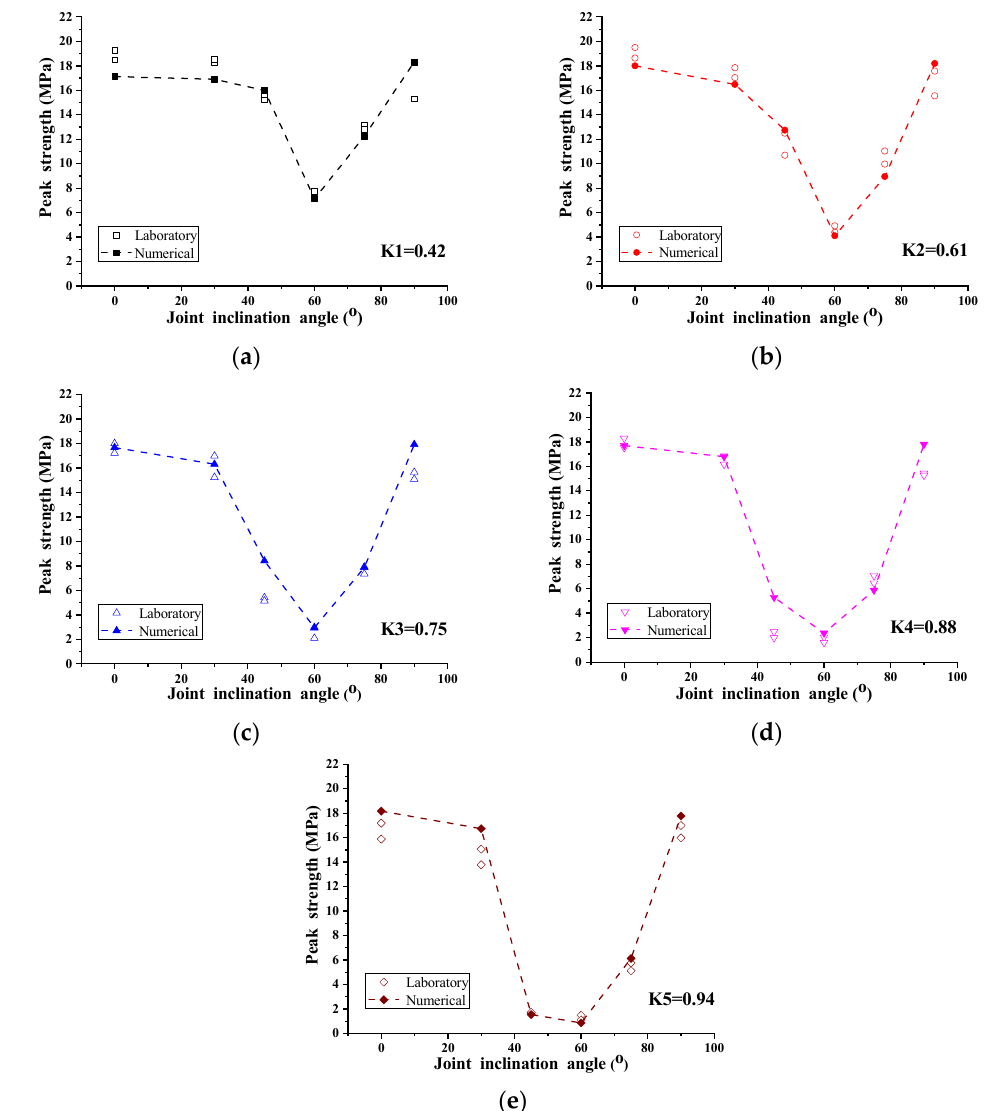
Figure 5. Comparison of the test and numerical results for peak strength.